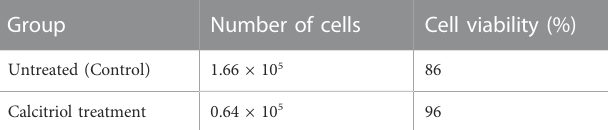
TABLE 1 Information of isolated cells.